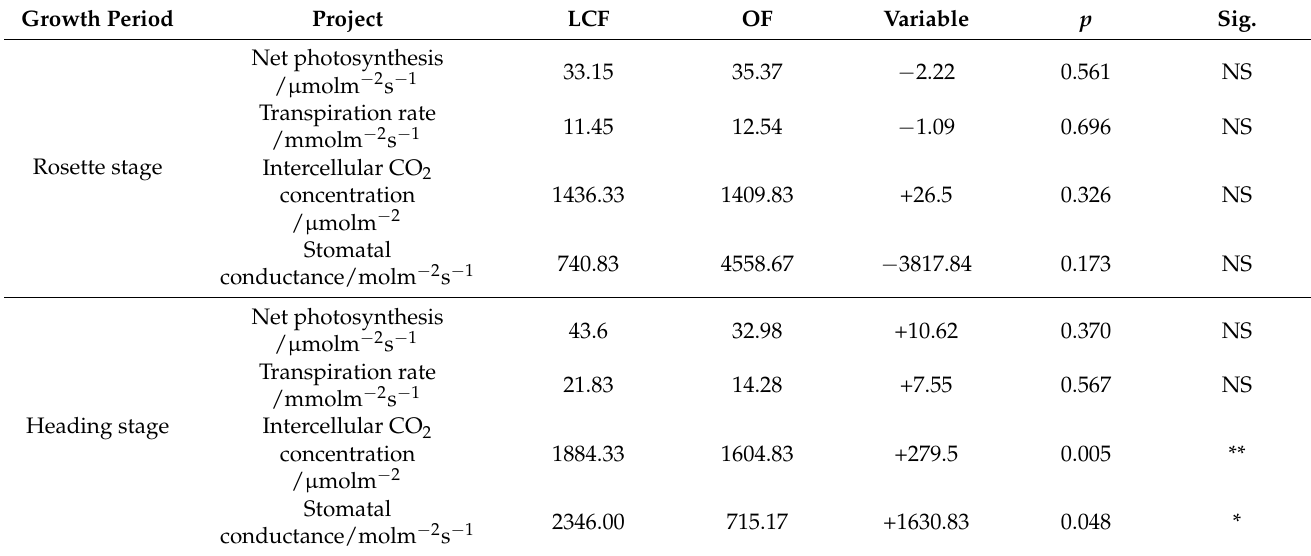
Table 6. Effects of light conversion film (LCF) and ordinary film (OF) on Photosynthetic Characteris- tics of plant leaves at different growth stages.